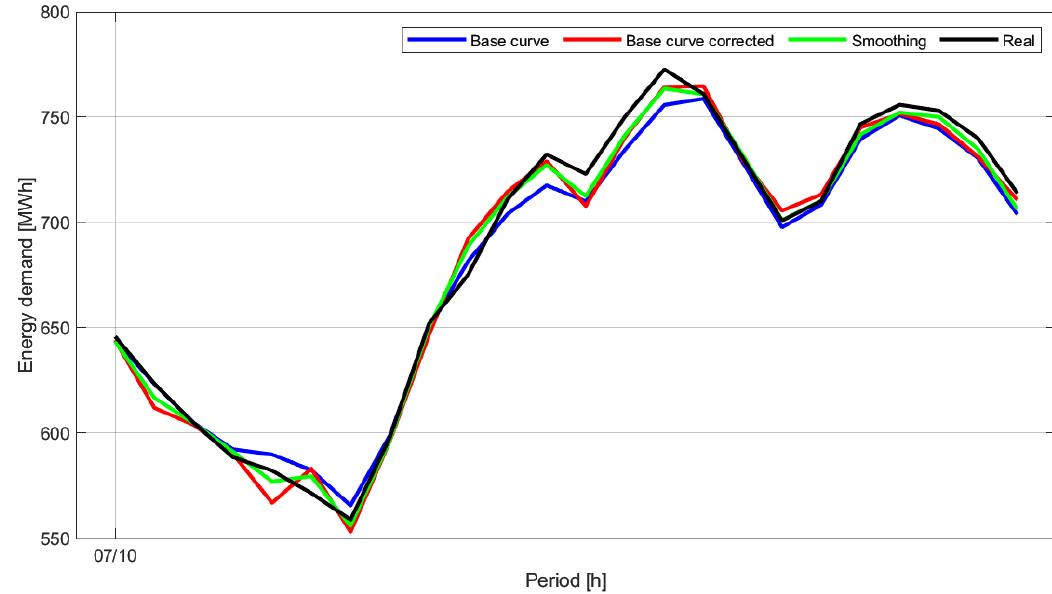
Figure 15. Smooth of the corrected base curve obtained previously for the Sunday in Market 1.